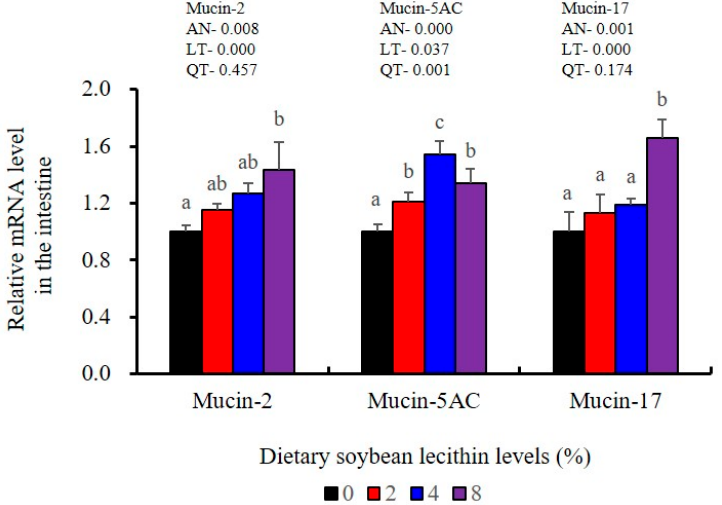
Figure 12. Effects of dietary soybean lecithin levels on intestinal mucins gene expression levels of Figure 12. E ff ects of dietary soybean lecithin levels on intestinal mucins gene expression levels of juvenile largemouth bass. Bars with different letters indicate significant differences ( p < 0.05), while juvenile largemouth bass. Bars with di ff erent le tt ers indicate signi fi cant di ff erences ( p < 0.05), while that with the same le tt er or no le tt er superscripts indicate no signi fi cant di ff erences ( p > 0.05), AN: that with the same letter or no letter superscripts indicate no significant differences ( p > 0.05), AN: Figure 12. E ff ects of dietary soybean lecithin levels on intestinal mucins gene expression levels of ANOVA, LT: linear trend, QT: quadratic trend. ANOVA, LT: linear trend, QT: quadratic trend. juvenile largemouth bass. Bars with di ff erent le tt ers indicate signi fi cant di ff erences ( p < 0.05), while that with the same le tt er or no le tt er superscripts indicate no signi fi cant di ff erences ( p > 0.05), AN: Table 10. The effects of soybean lecithin on the intestinal morphology of juvenile largemouth bass. ANOVA, LT: linear trend, QT: quadratic trend. Lecithin (%) in Diets